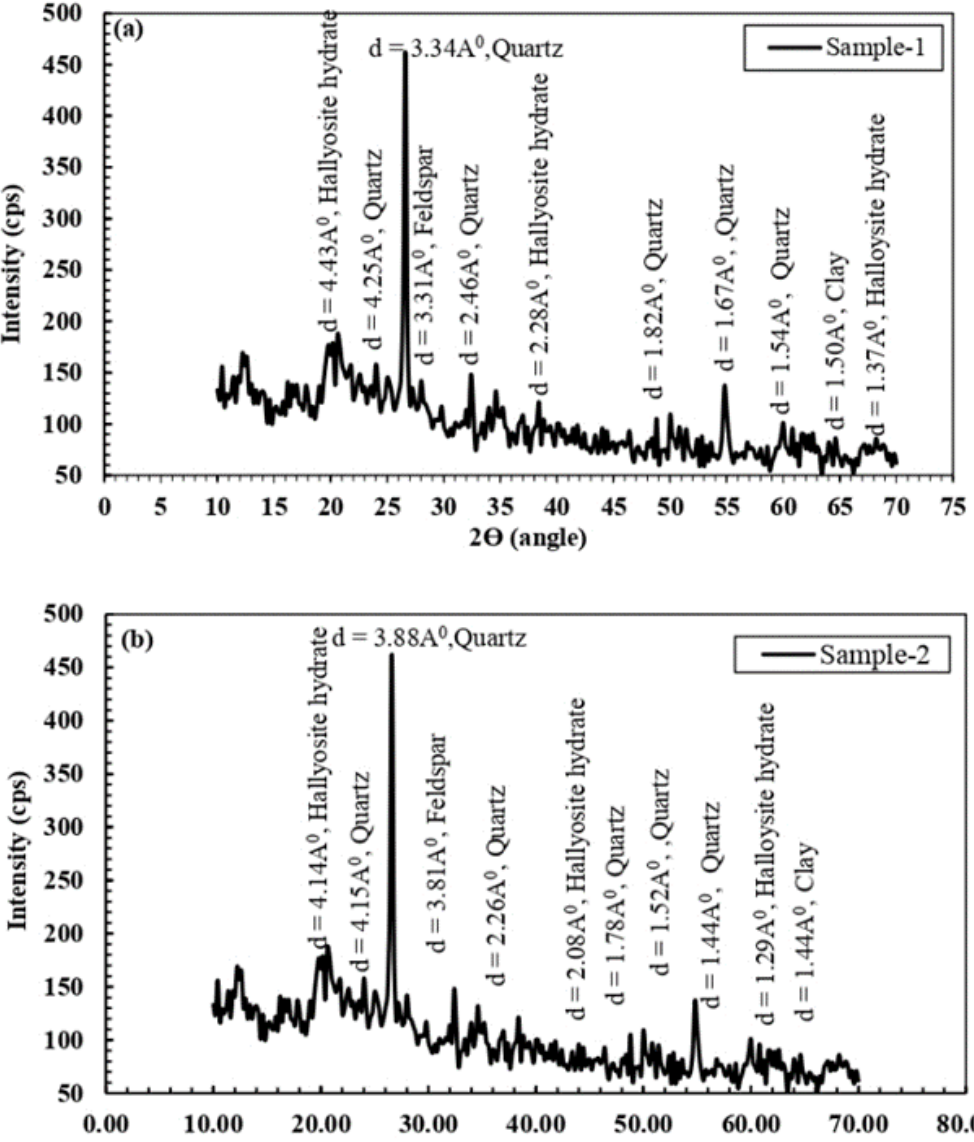
Figure A3. Sample graphs of XRD analysis conducted on soils collected from two locations in Agartala town: (a) Sample 1 (BH 60) and (b) Sample 2 (BH